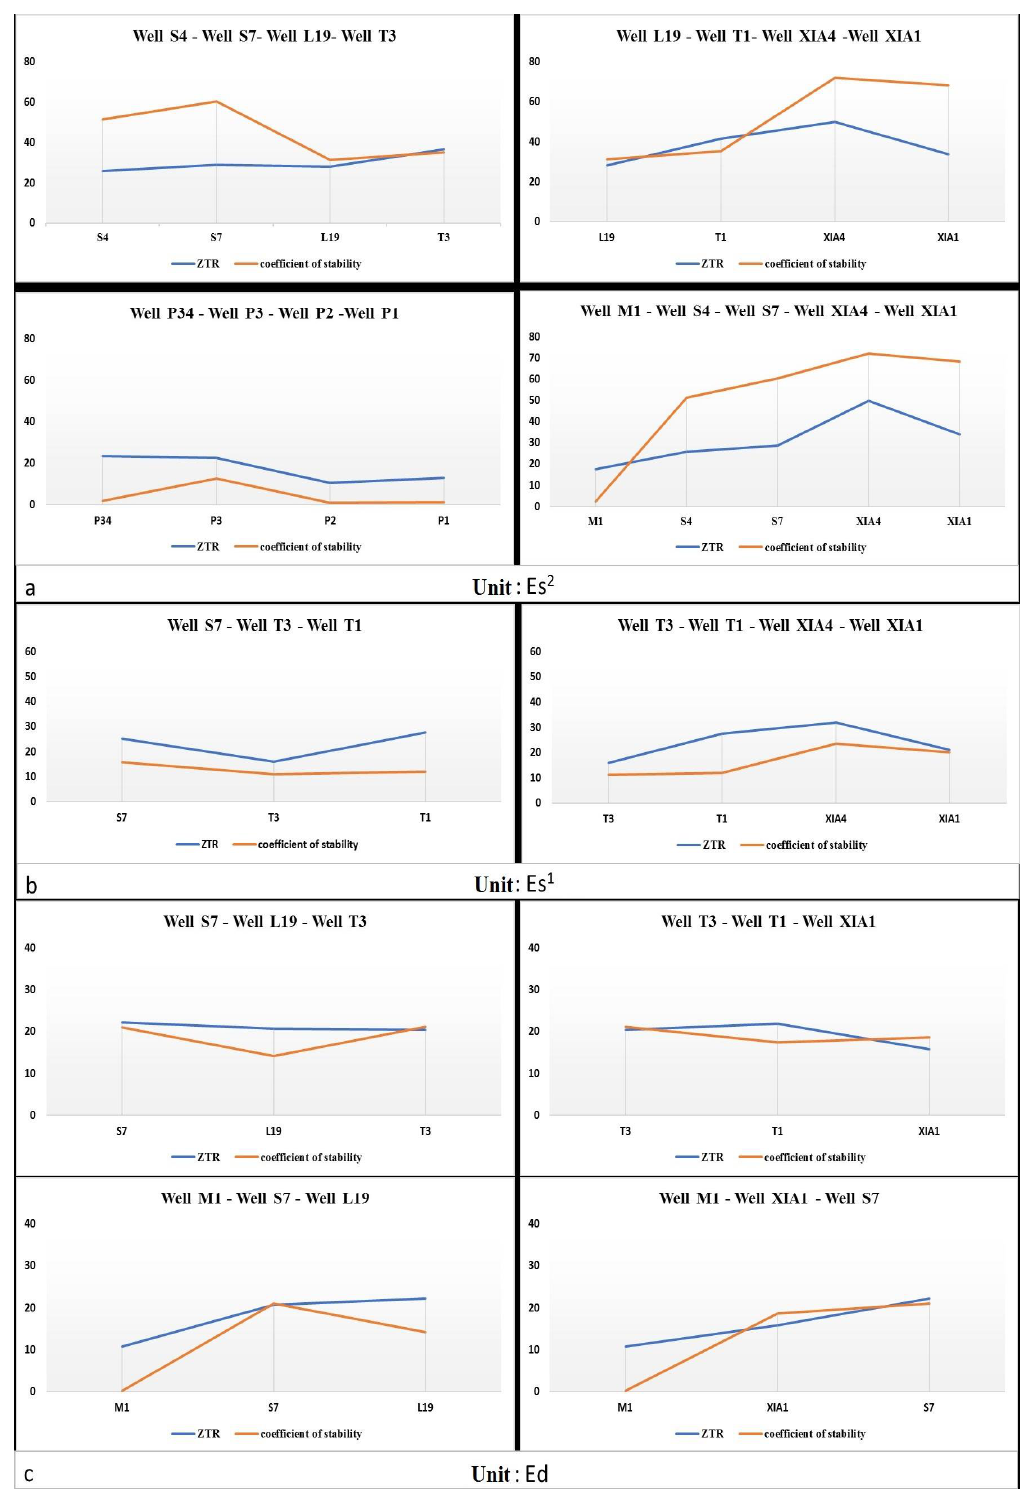
Figure 6. ZTR (zircon, tourmaline, and rutile) index and stability coefficient of the heavy minerals in the Huimin depression. Diagrams showing ( a ) the ZTR index and stability coefficient of the heavy minerals in the Es 2 , ( b ) the ZTR index and stability coefficient of the heavy minerals in the Es 1 , and ( c ) the ZTR index and stability coefficient of the heavy minerals in the Ed. The X-axis represent wells. The Y-axis represent ratio. The locations of the samples are shown in Figure 7.